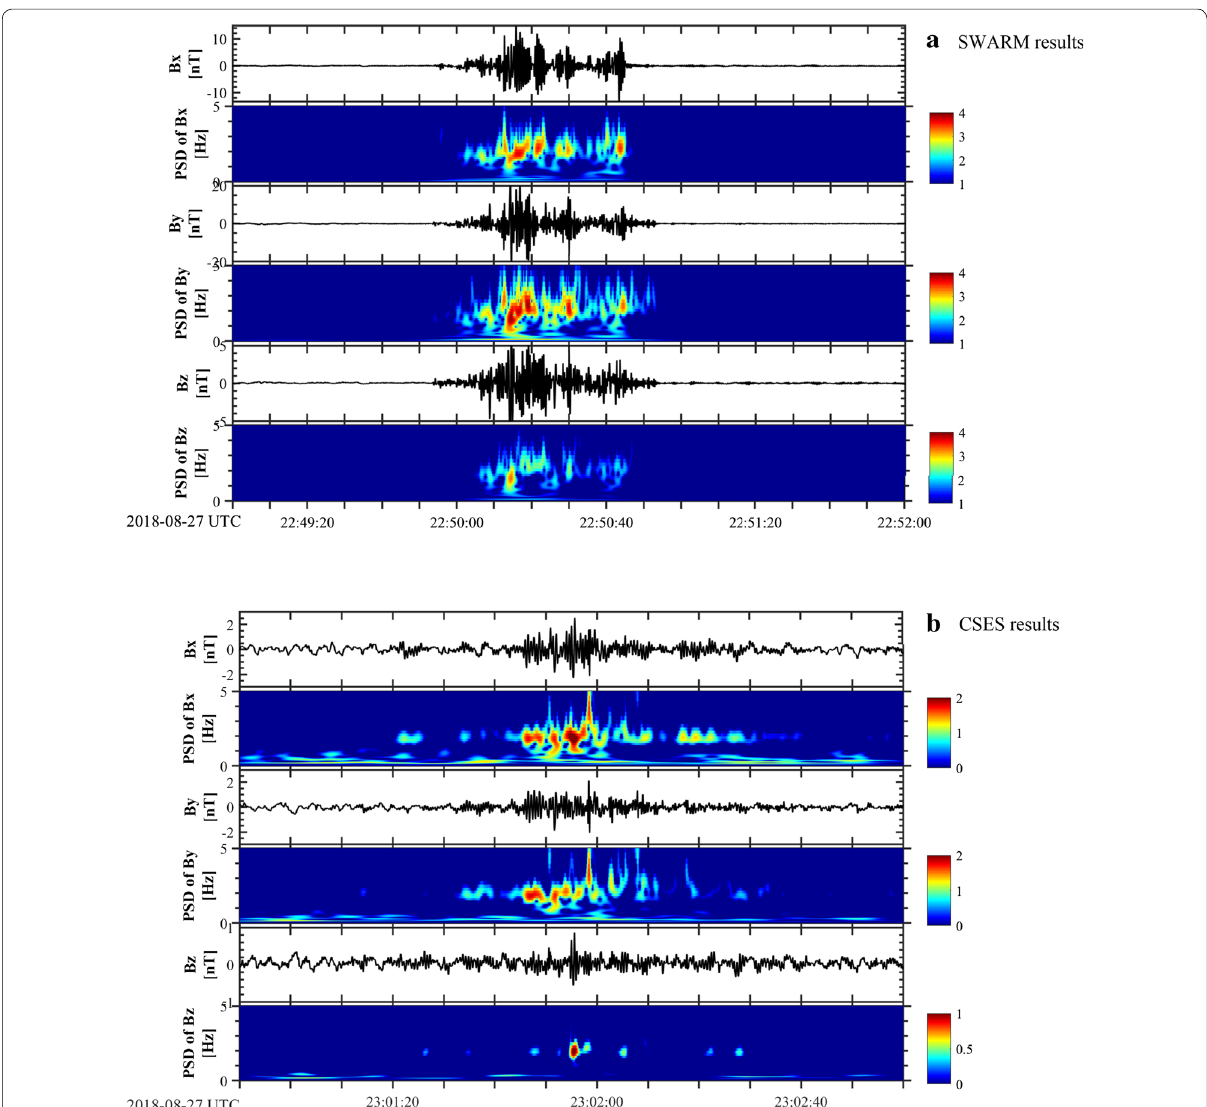
Fig. 24 Pc1 pulsation observed by SWARM-C (top) and CSES (bottom) magnetic field data on August 27, 2018 in the southern hemisphere; the two satellites are separated about 1000 km in